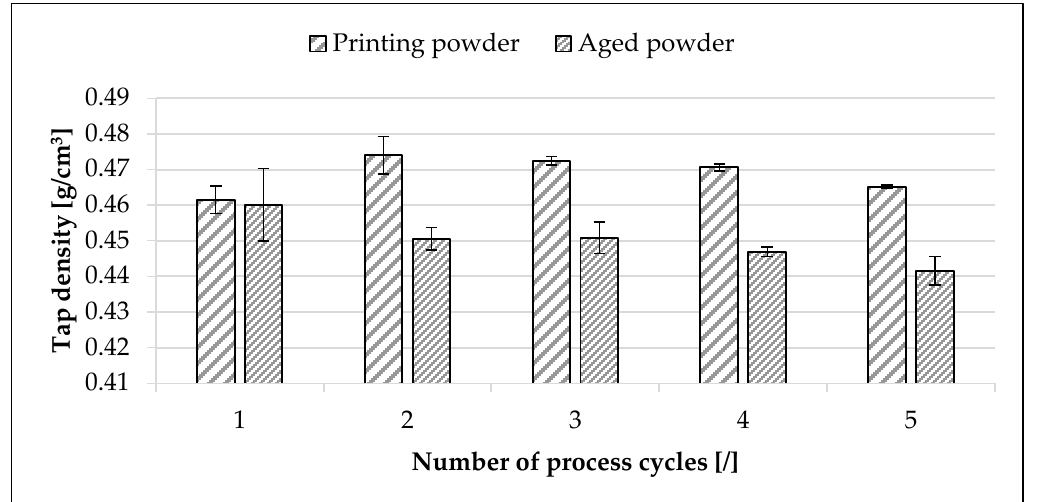
Figure 8. Influence of cyclic reuse on the tap density of the used polyamide 12 sinter material. Five process cycles were considered. The printing powder and the aged powder were analyzed. The refresh rate was 30 wt%.